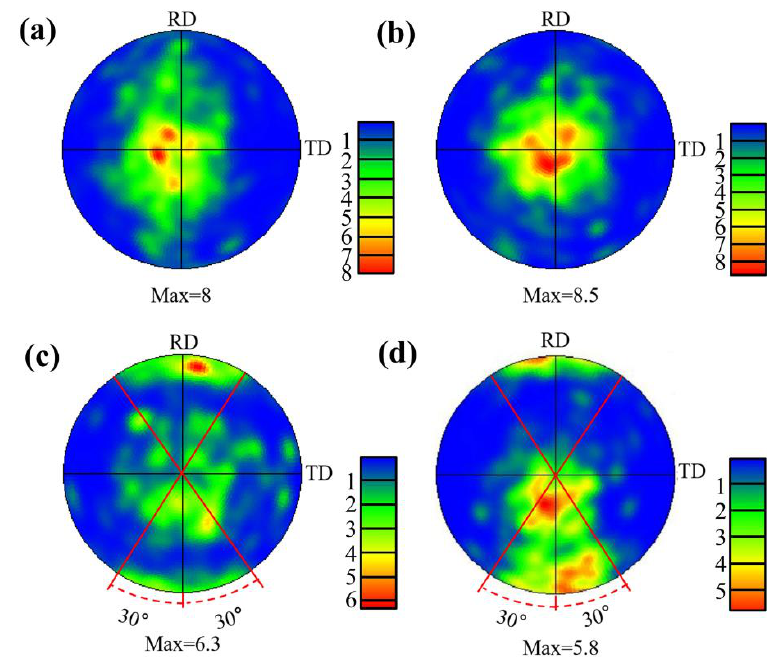
Figure 6. (0002) Pole figures of the different samples without annealing: ( a ) upper surface of HTR sample; ( b ) mid-layer of HTR sample; ( c ) upper surface of HTR-CB sample; ( d ) mid-layer of HTR-CB sample.